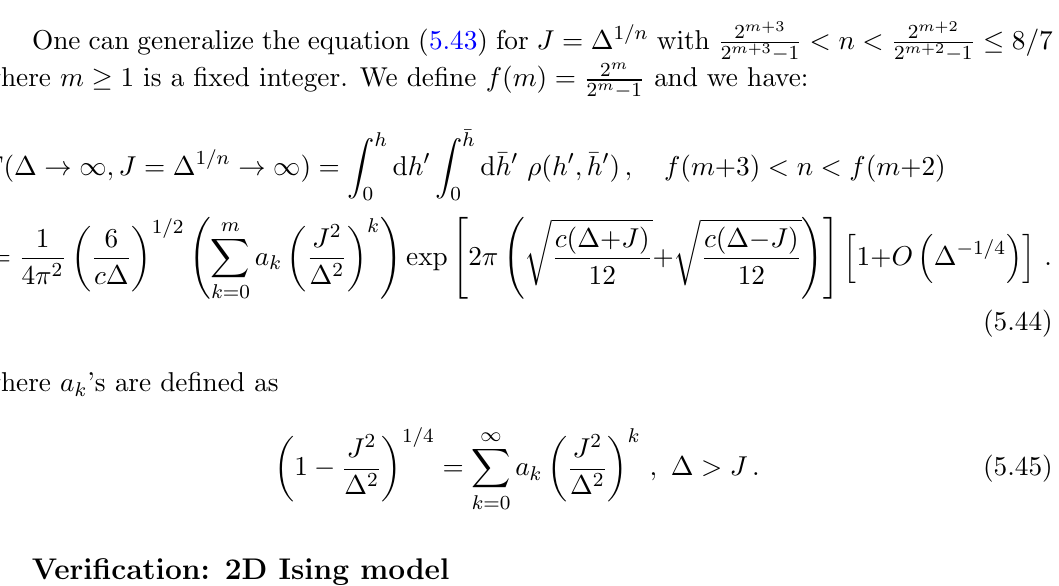
Figure 8 . Verifying the bounds on O (1) correction to entropy ( s ( (cid:14); (cid:22) (cid:14); h; (cid:22) h )) associated with order one window centered at some large h and (cid:22) h , the black line is the upper bound while the red line below is the lower bound. The curvy cyan line is the di(cid:11)erence between the actual number of states lying within the window and leading answer coming from the Cardy formula. Here h and (cid:22) h are of the same